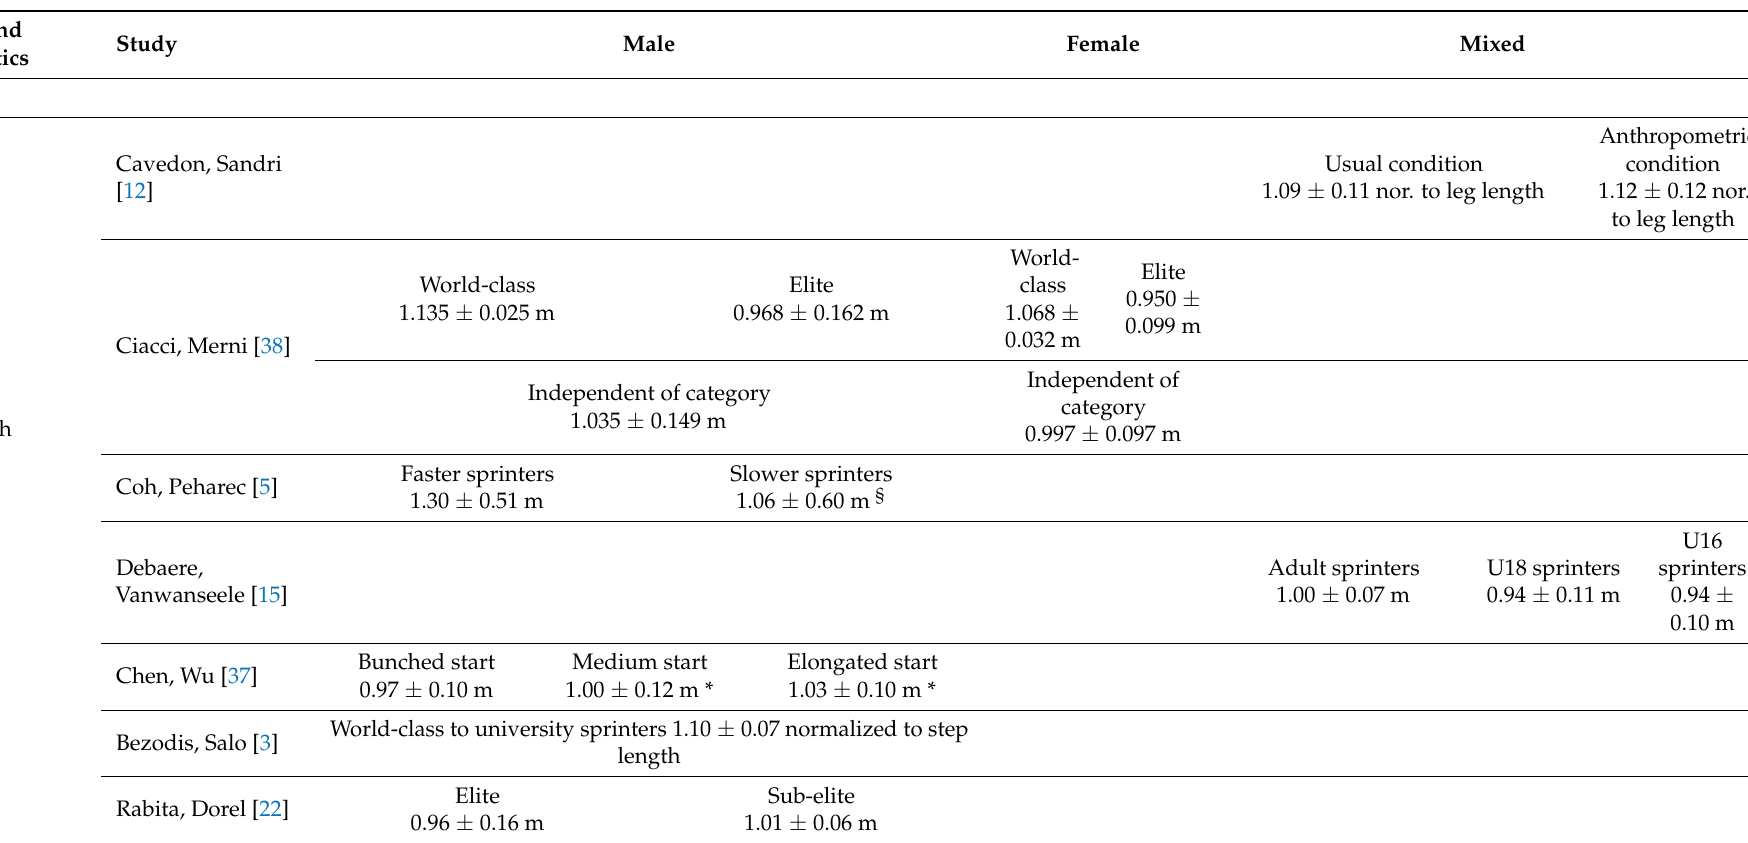
Table A4. Summary of the kinematic variables in the “first two steps”. Data are the magnitude of the mean ± SD presented in the reviewed studies. Groups are male, female, and mixed (when authors joined data without discriminating by sex) sprinters. Studies are listed, in each variable, in reverse-chronological order, followed by alphabetically for studies published in the same year. Data, terms, conditions, and sprinters’ performance levels are presented according to the original authors. Statistical differences between groups are marked with asterisks (* p < 0.05; ** p < 0.01; *** p < 0.001; # significant different from adults; § small effect